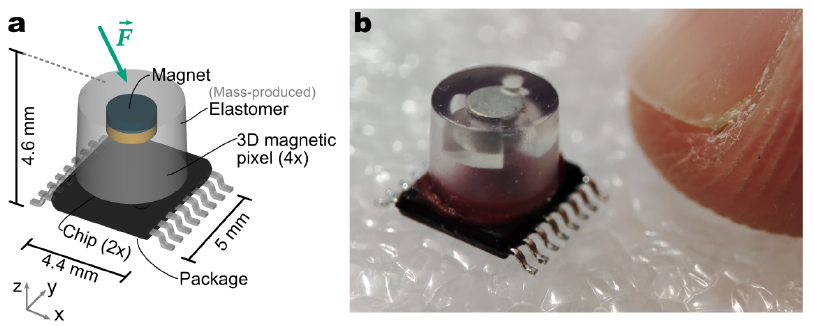
Figure 1. ( a ) Concept diagram of the magnetic force sensor. It consists of two magnetometer sensor chips in the same package, providing in total 4 3D magnetic pixels. A mass-produced elastomer with an embedded magnet is glued on top. The full assembly (except the leads) fits inside a cube, whose edge is 5 mm long. ( b ) Picture of the actual